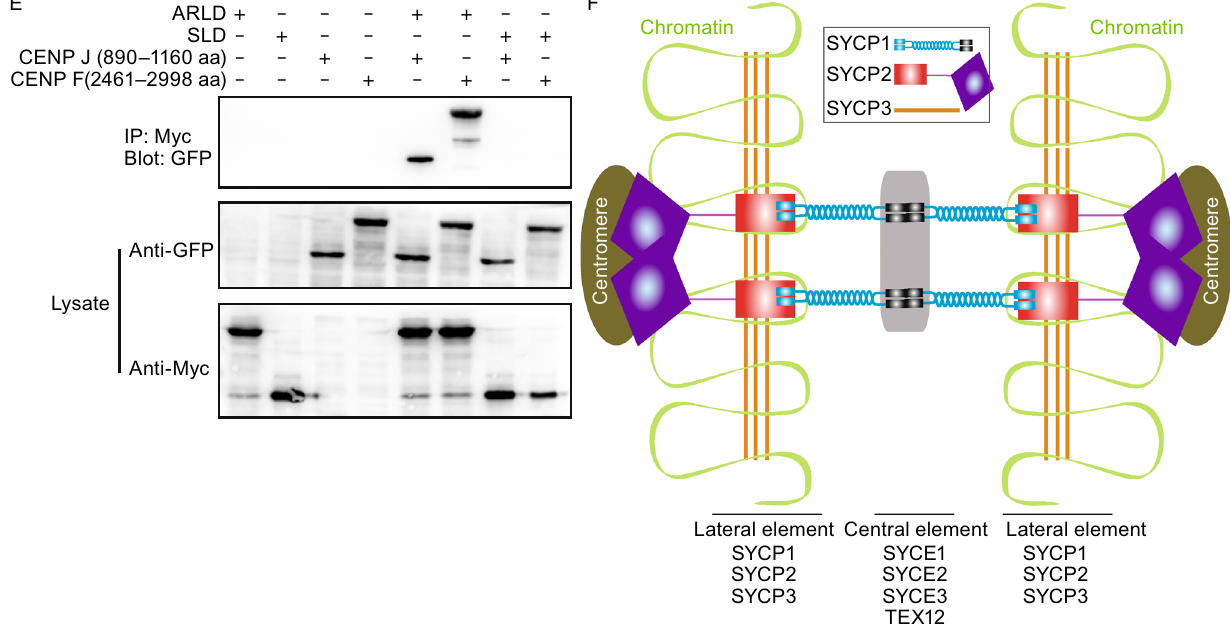
C-terminal regions of SYCP2 and SYCP3. The mSYCP2 NTR is bridge to connect the centromere with the